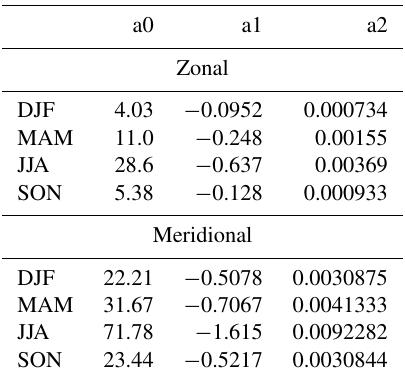
Table 3. Seasonal parameters used for a polynomial function to minimize the amplitude difference of the MF radar to the MR. a0 a1